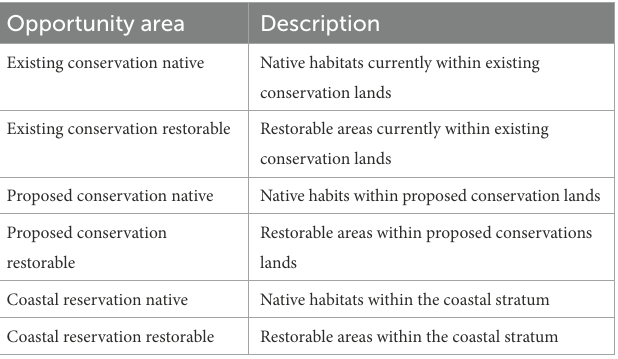
TABLE 1 Description of the opportunity areas in the Tampa Bay watershed identified through spatial